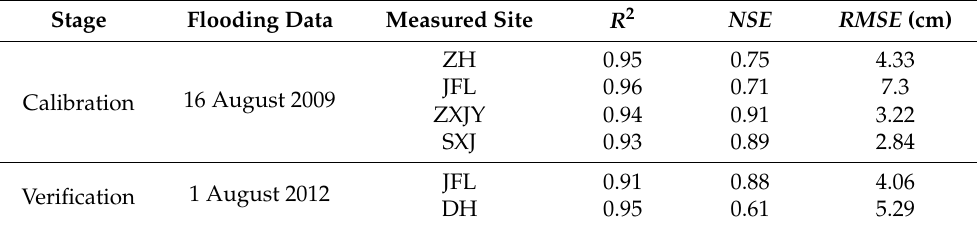
Table 3. Summary of the coupled model